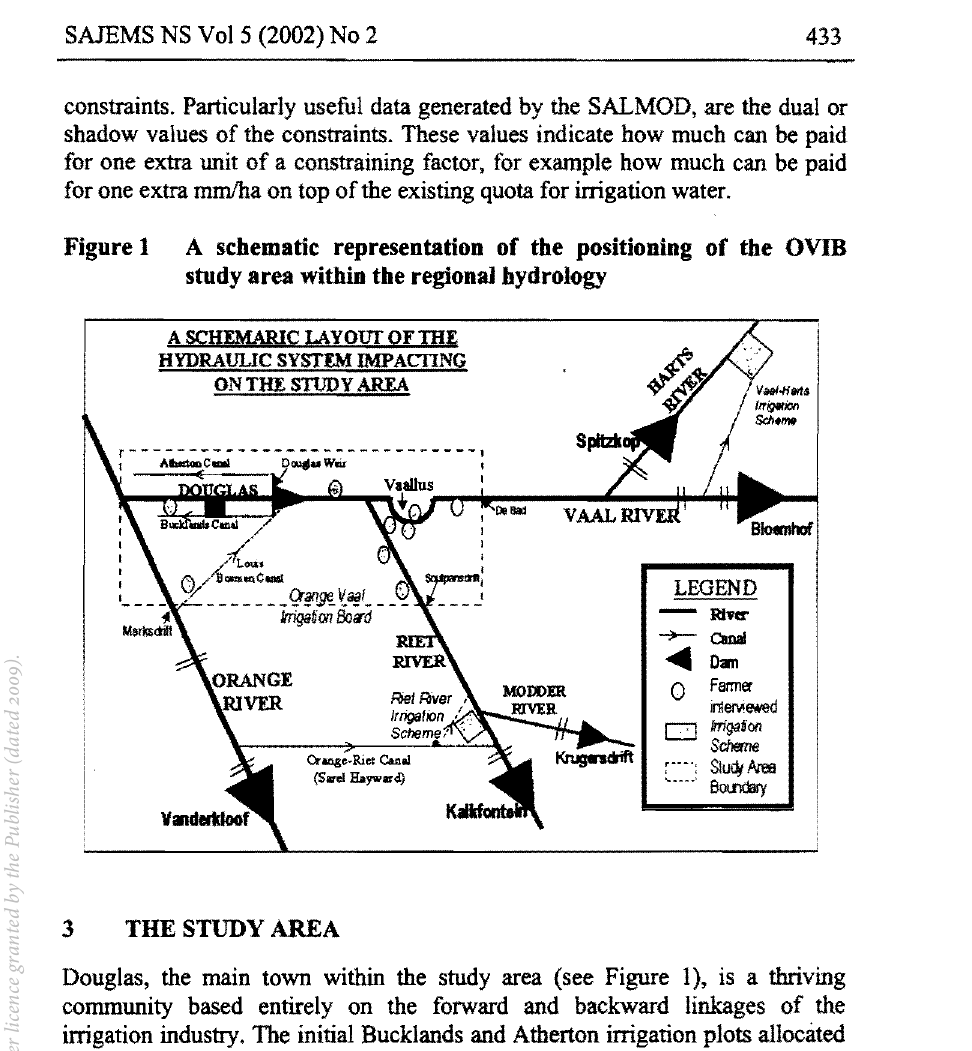
A schematic representation of the positioning of the OVIB study area within the regionaJ